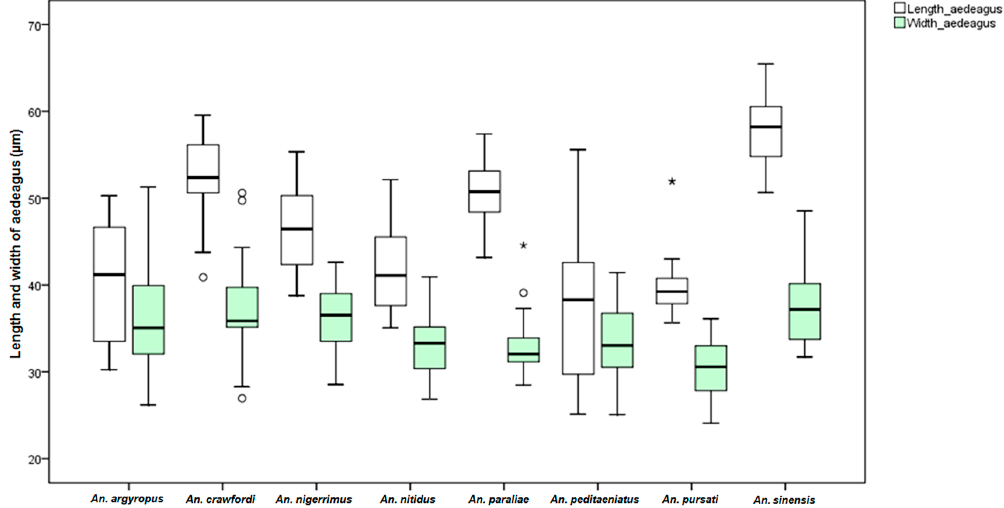
Figure 9. The Box-and-Whisker Plots representation of variation in aedeagus length and width of adult male of the eight Hyrcanus Group species.